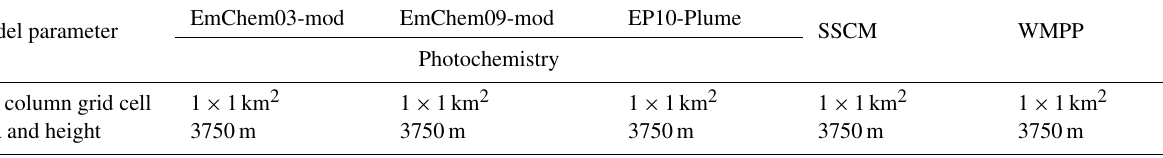
Table 3. Setup of the 1-D column model for the tests of model extensions. EmChem03-mod EmChem09-mod EP10-Plume Model parameter SSCM WMPP Photochemistry 1-D column grid cell area and height 3750m 3750m 3750m 3750m 3750m Eulerian grid Vertical upstream advection and semi-implicit Crank–Nicolson No transport transport diffusion scheme with the new urban K(z) parameterization Eulerian grid EmChem03-mod EmChem09-mod Local photochemistry